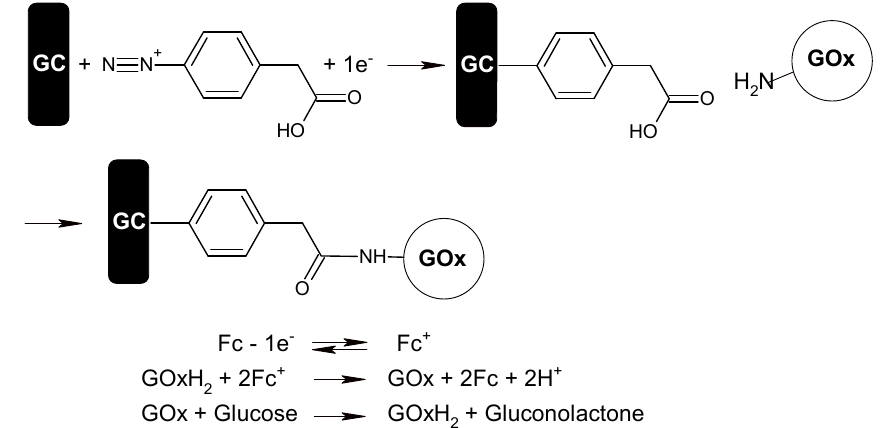
Figure 12. Detection of glucose by attaching glucose oxidase (GOx) to a glassy carbon surface. Catalytic scheme for the electro-catalyzed oxidation of its reduced form (GOxH 2 ).